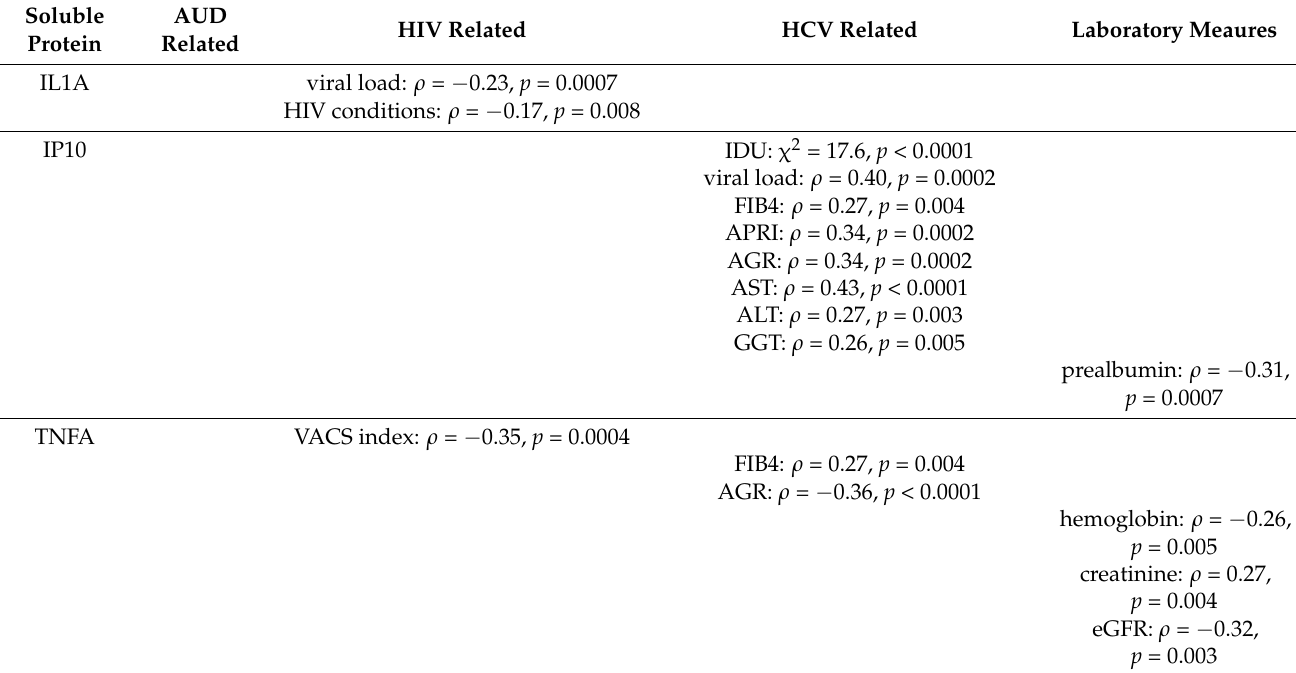
Table 3. Nonparametric Spearman’s ρ correlates of soluble protein